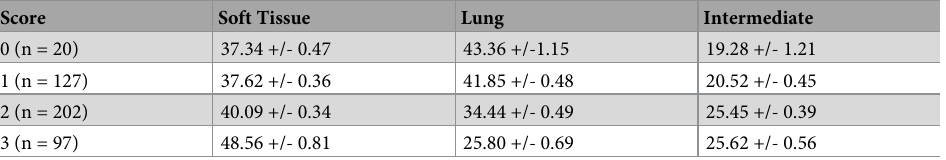
Table 1. Validation of MLAST with manual scoring (related to Fig 4A).